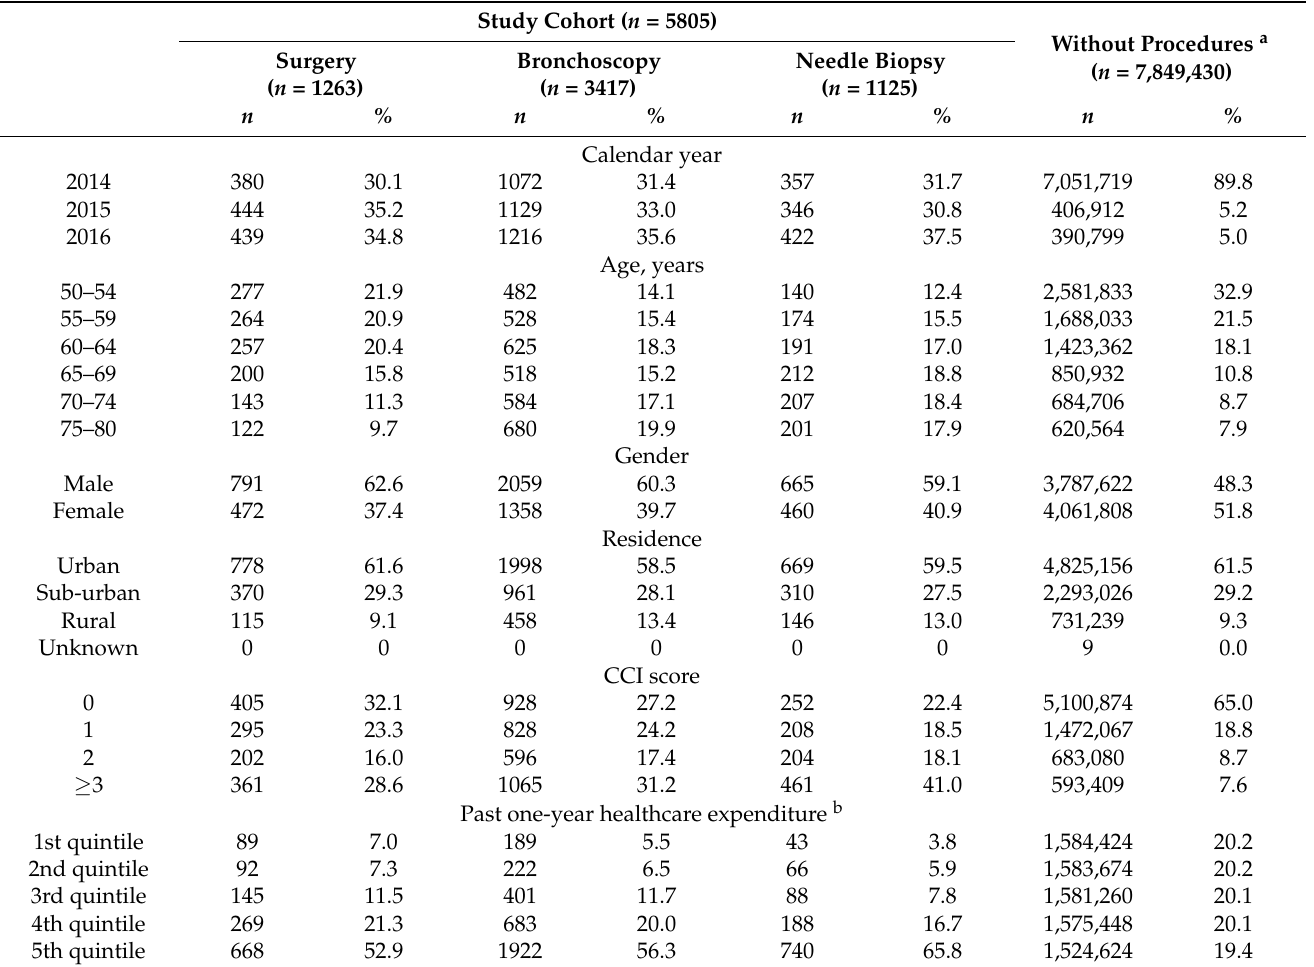
1125 individuals underwent thoracic surgery, bronchoscopy, and needle biopsy, respec- tively. The individuals receiving thoracic surgery were much younger, more likely to live in urban areas, and had lower comorbidity scores than those undergoing other invasive lung procedures. The 5805 individuals were 1:10 directly matched by calendar year, age, gender, residence area, comorbidity scores, and past one-year healthcare expenditure to individuals who had not received the procedures. All selected covariates of the study and matched cohorts were completely matched (Table 2). Table 1. Characteristics of the beneficiaries by procedure within one month after non-contrast chest CT. Study Cohort ( n = 5805) Without Procedures a 7,849,430)Surgery Bronchoscopy Needle Biopsy ( n = ( n = 1263) ( n = 3417)